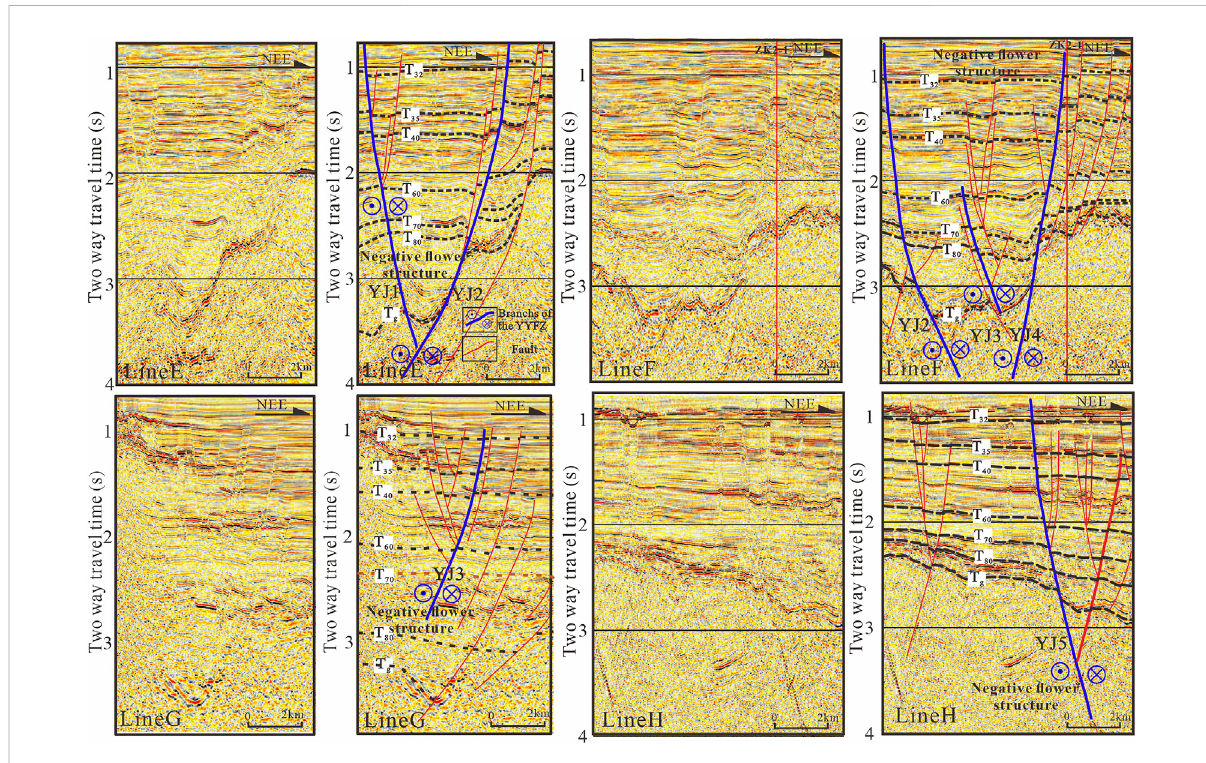
FIGURE 10 Interpretedseismicpro fi lesshowingfaultintersectionsintheYangjiangSag.Pro fi lelocationsareshowninFigure6C.Thepro fi lesrevealthatthe NW-trending faults are characterized by fl ower-like structures that indicate they experienced transtensional